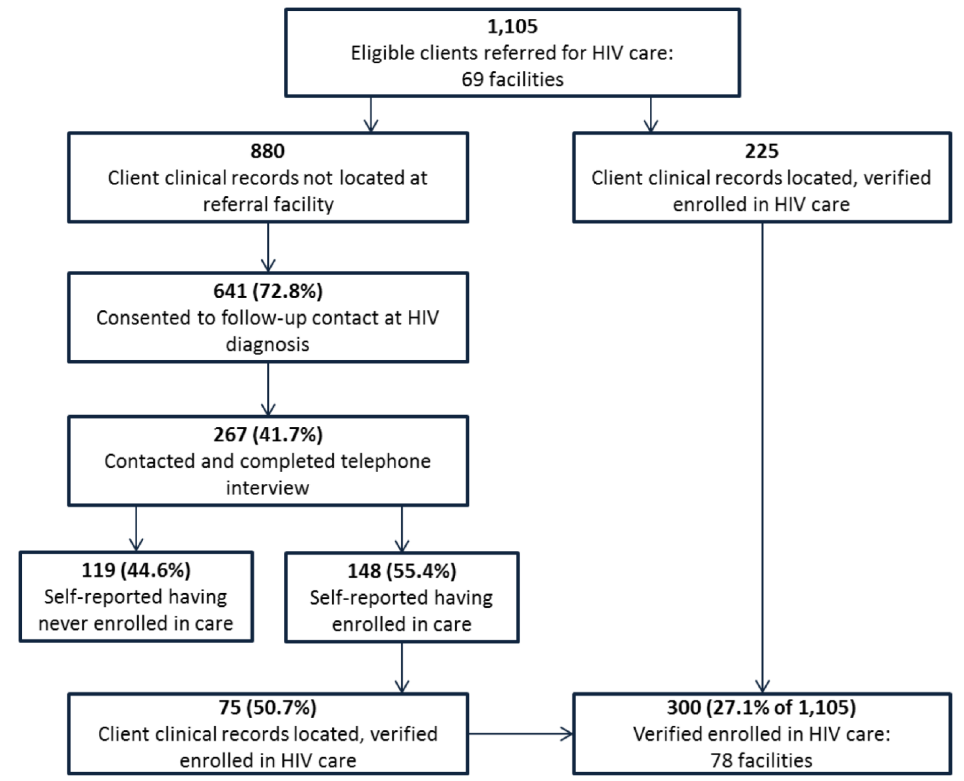
Fig 3. Eligible newly HIV diagnosed clients verified to have enrolled in HIV